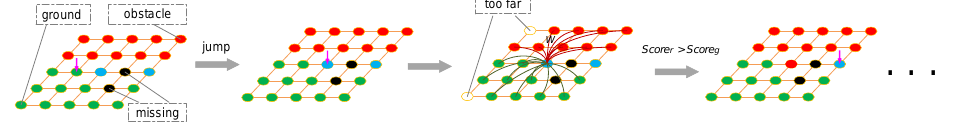
Figure 6. Find and re-classify “low-confidence